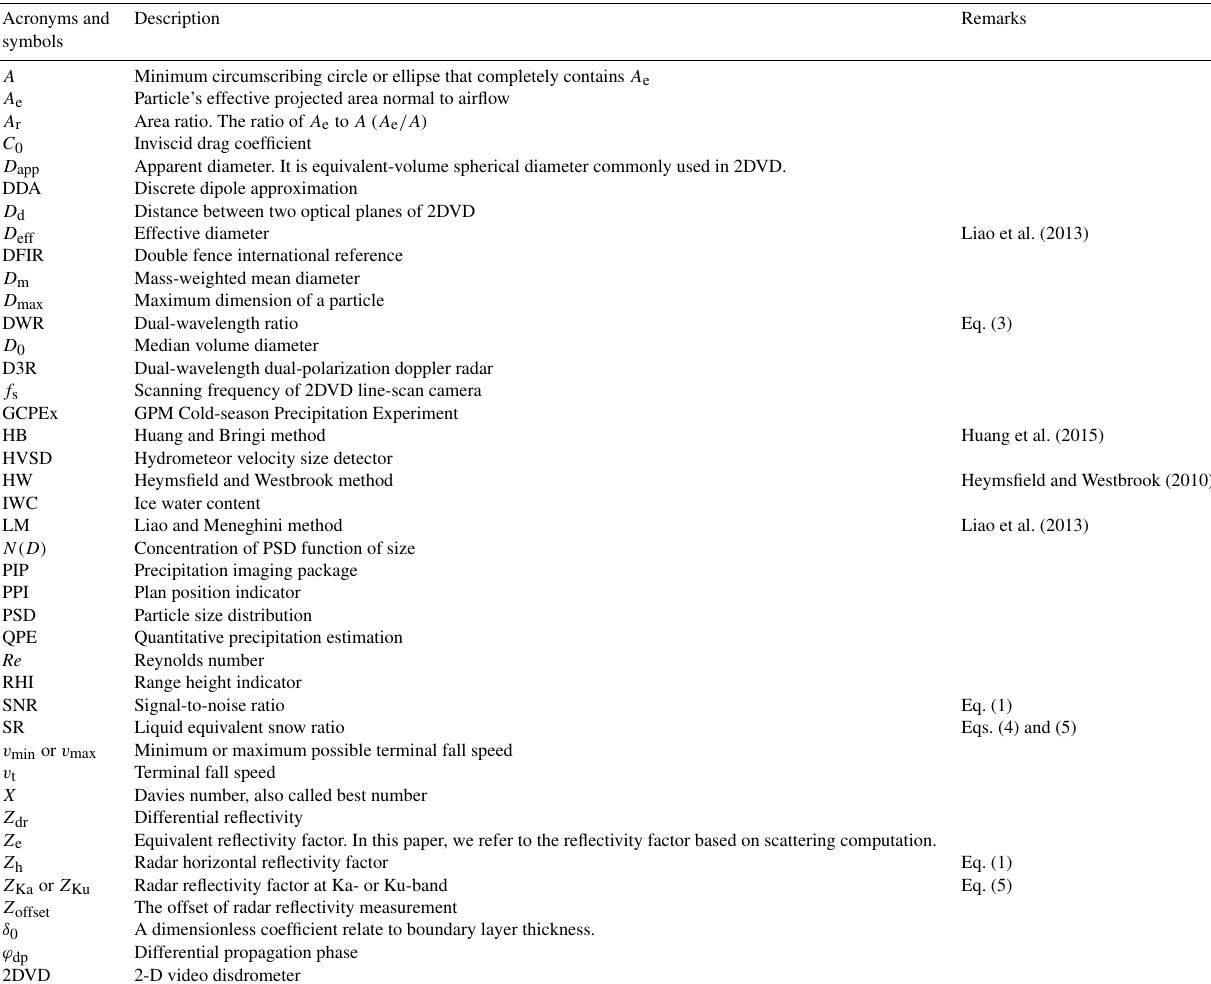
Table A1. List of acronyms and